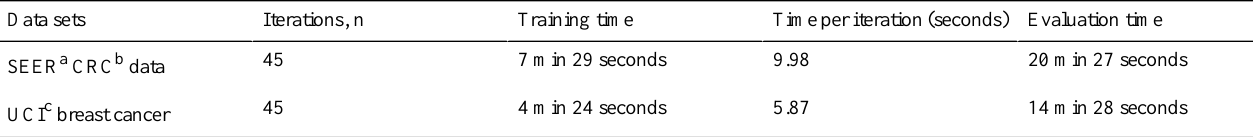
Table 5. Time consumption of the proposed protocol.